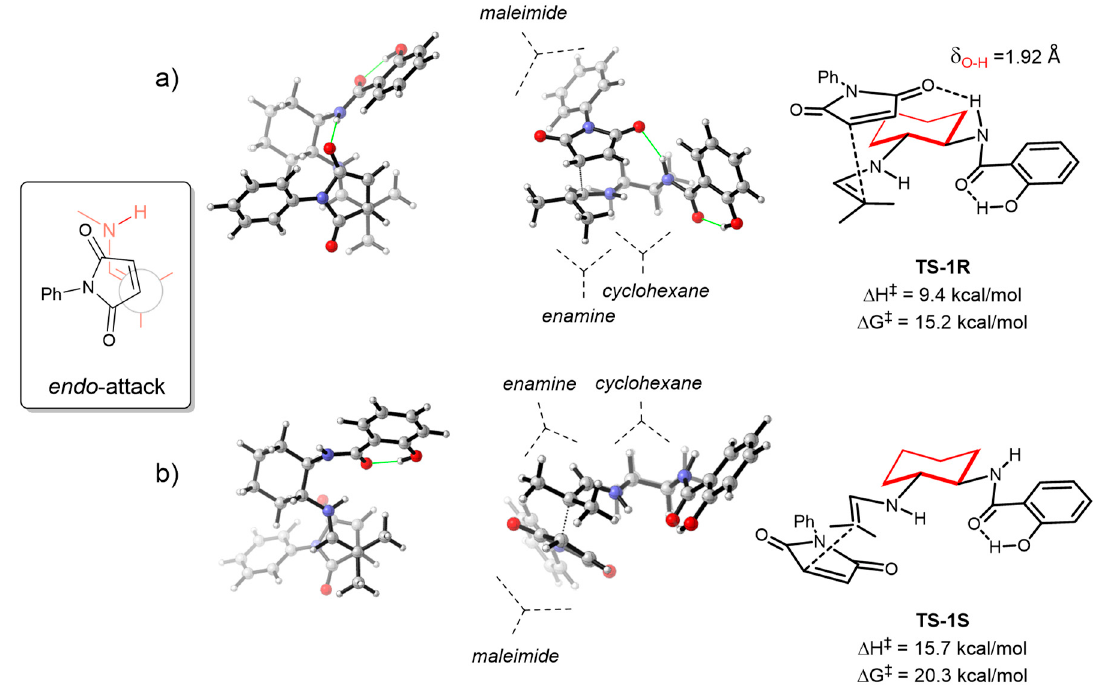
Figure 4. Transition states for the formation of ( R )- 18aa ( a ) and the ( S )- 18aa ( b ) catalyzed by 15 . 3D-Newman projections (left-figures), side views (middle-figures) and 2-D representations are shown. Molecules 2018 , 23 , x FOR PEER REVIEW